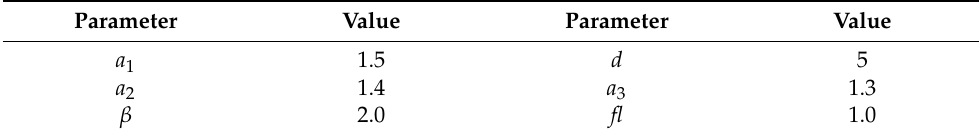
Table 2. Values of main parameters in the IMOA. Parameter